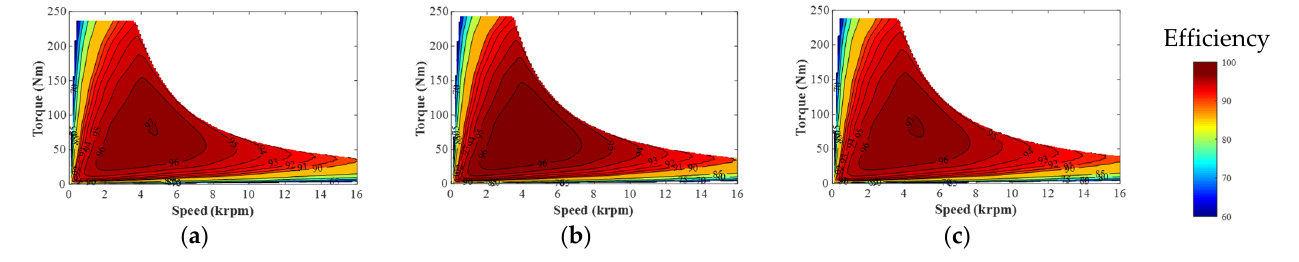
Figure 34. Efficiency maps of different winding configurations: ( a ) ORG; ( b ) DTP-SF; ( c ) DTP-DS.